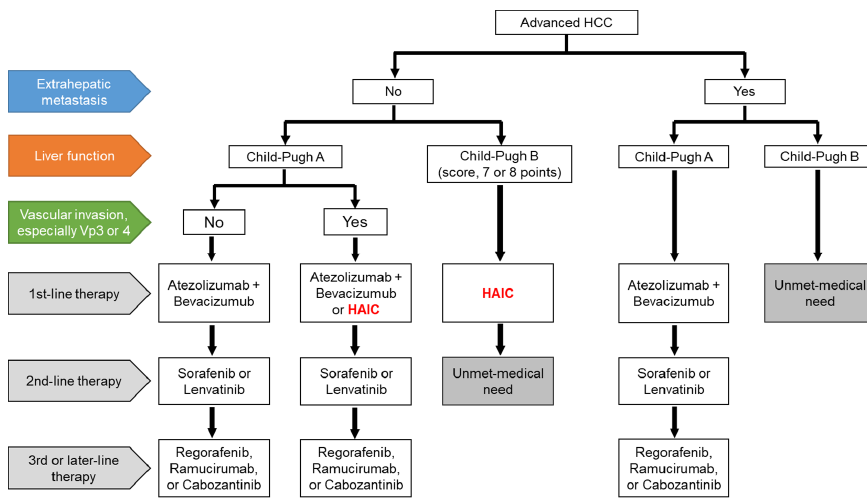
Figure 1. A draft of the treatment proposal for advanced HCC. HCC, hepatocellular carcinoma; HAIC, hepatic arterial infusion chemotherapy; Vp3, primary branch portal vein invasion; Vp4, main portal vein invasion.